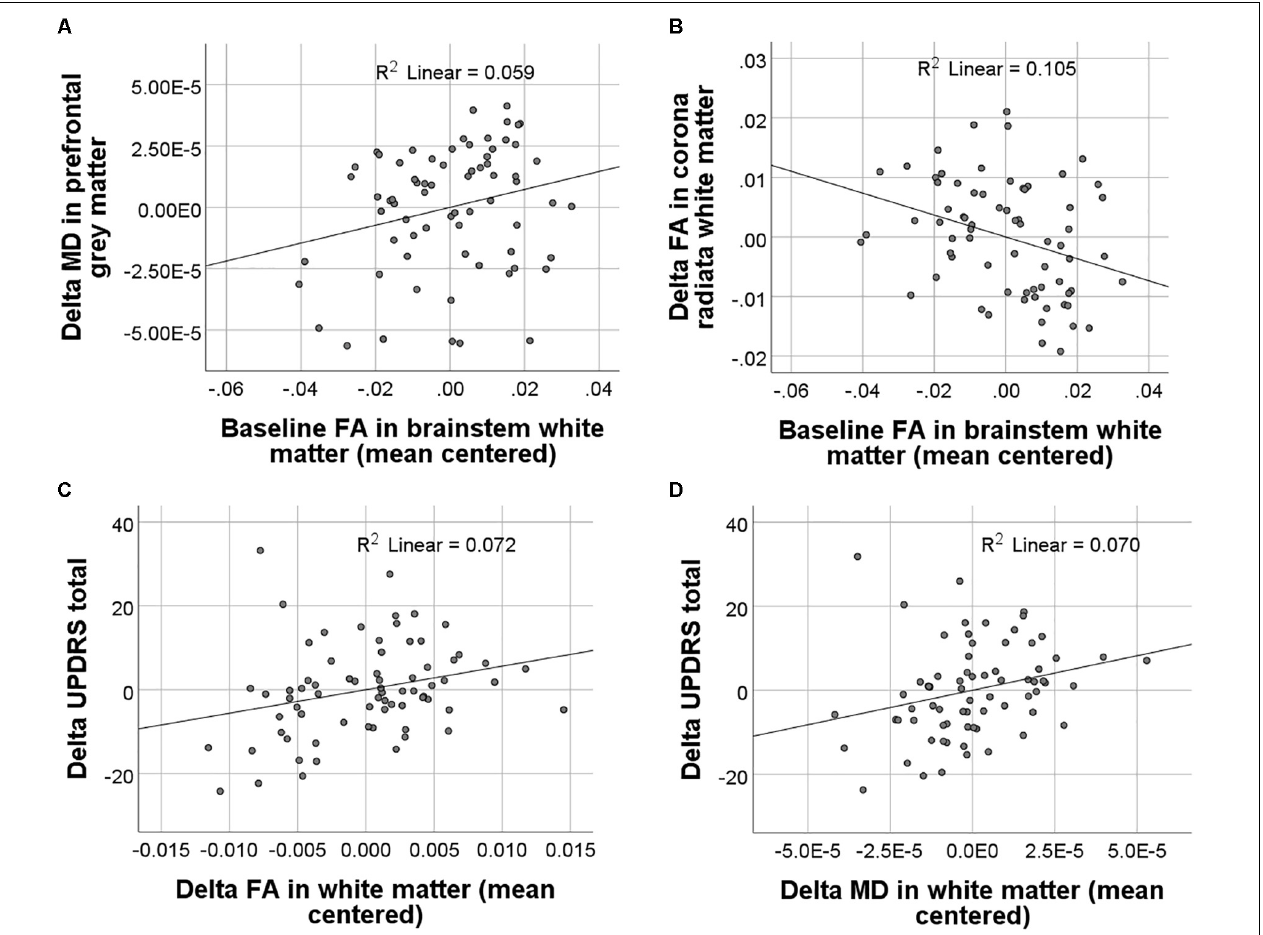
FIGURE 3 | Results of regression analyses between baseline and longitudinal FA and MD values and clinical scores. Significant associations between baseline FA and longitudinal FA and MD changes are displayed in (A) and (B) . Significant associations between longitudinal FA and MD changes and changes in symptom severity as measured with the MDS-UPDRS (Movement Disorder Society-sponsored revision of the Unified Parkinson’s Disease Rating Scale) are displayed in (C) and (D)